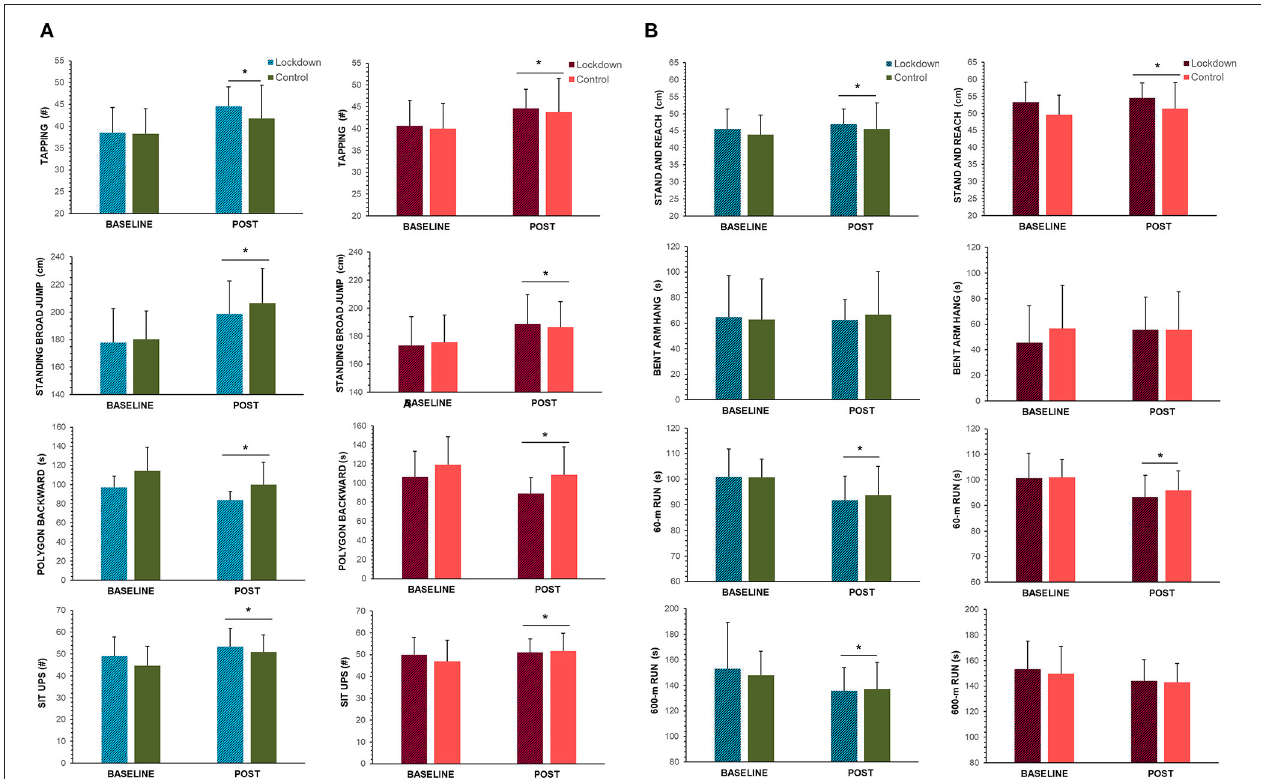
FIGURE 4 | Fitness data collected for (A) the first four and (B) last four fitness indices during the regular implementation of SLOfit, Slovenia’s national fitness surveillance system for children. On the x-axis, “BASELINE” refers to data collected April 2018 for “lockdown” group, and April 2017 for matched controls (See Figure 1 for timeline of data collection and full study description). “POST” measures refer to fitness testing conducted immediately post-lockdown (June 2020) for the “lockdown group,” and April 2019 for matched controls. Mean fitness data are depicted for boys (blue and green bars) girls (red and orange bars), with standard deviation error bars. *Indicates a significant time main effect between baseline and post measurements ( p <